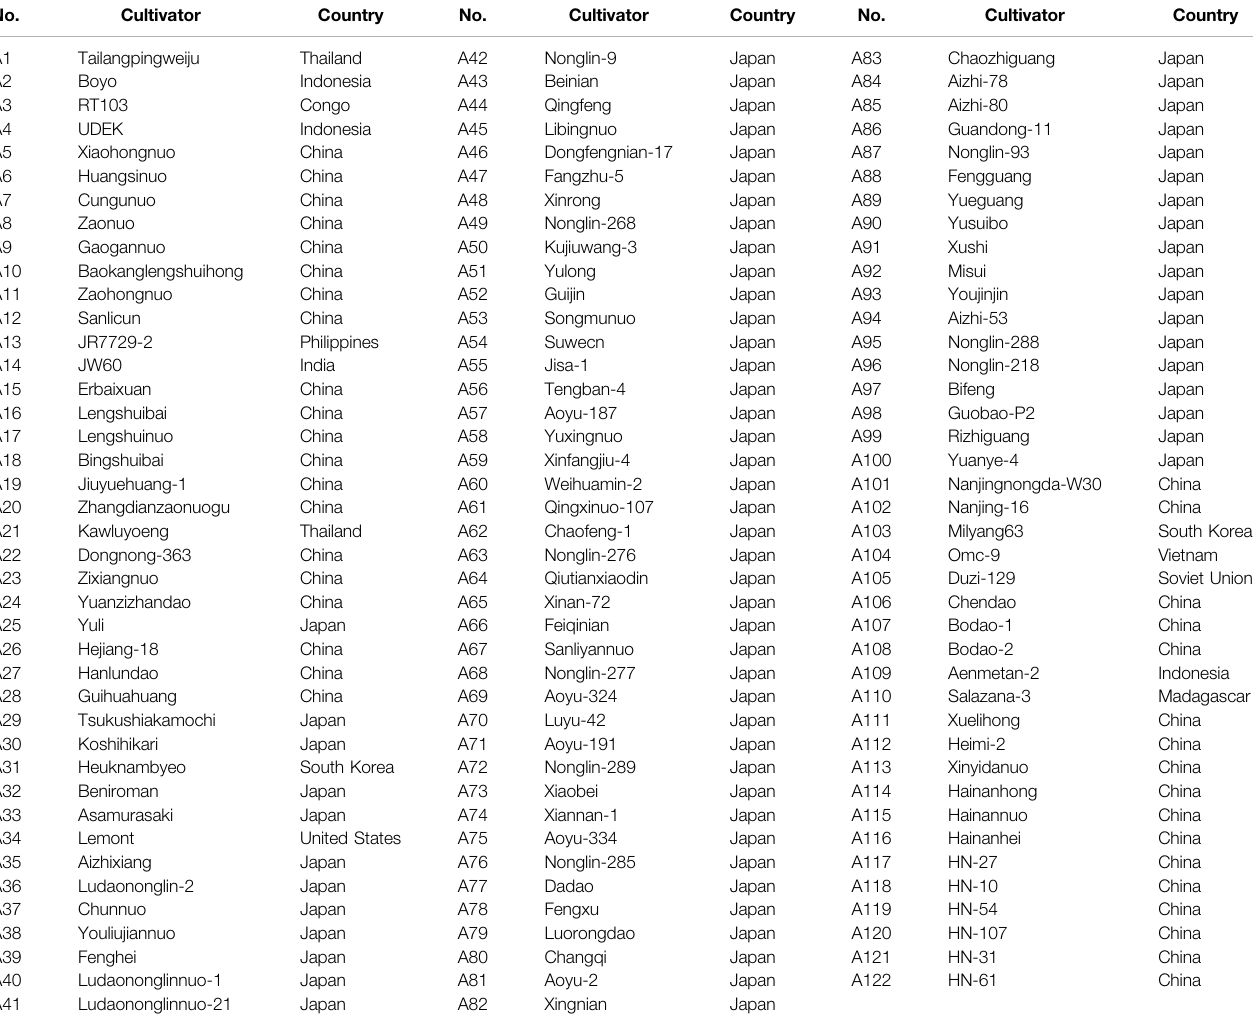
TABLE 1 | Rice accessions used in the present